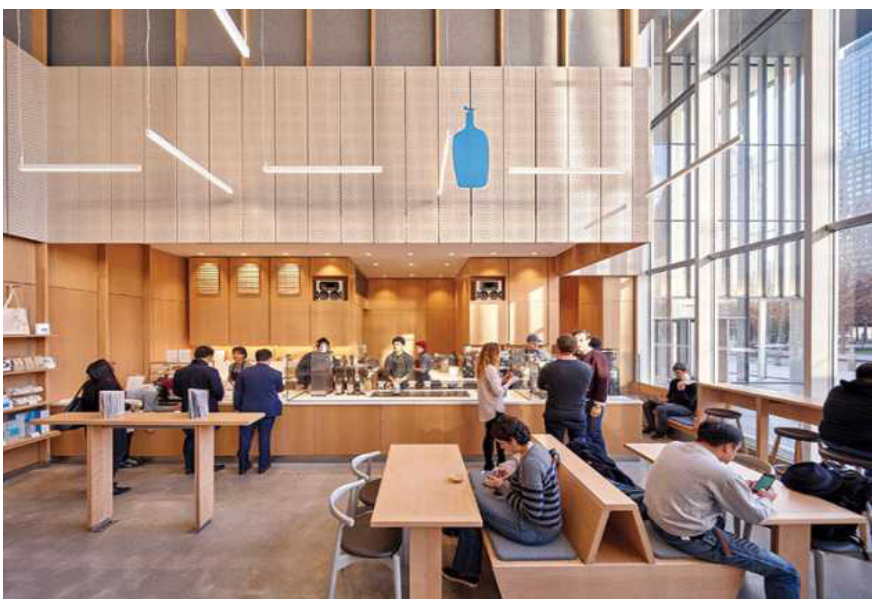
Figure 18. The minimal spatial design unique to Blue Bottle.